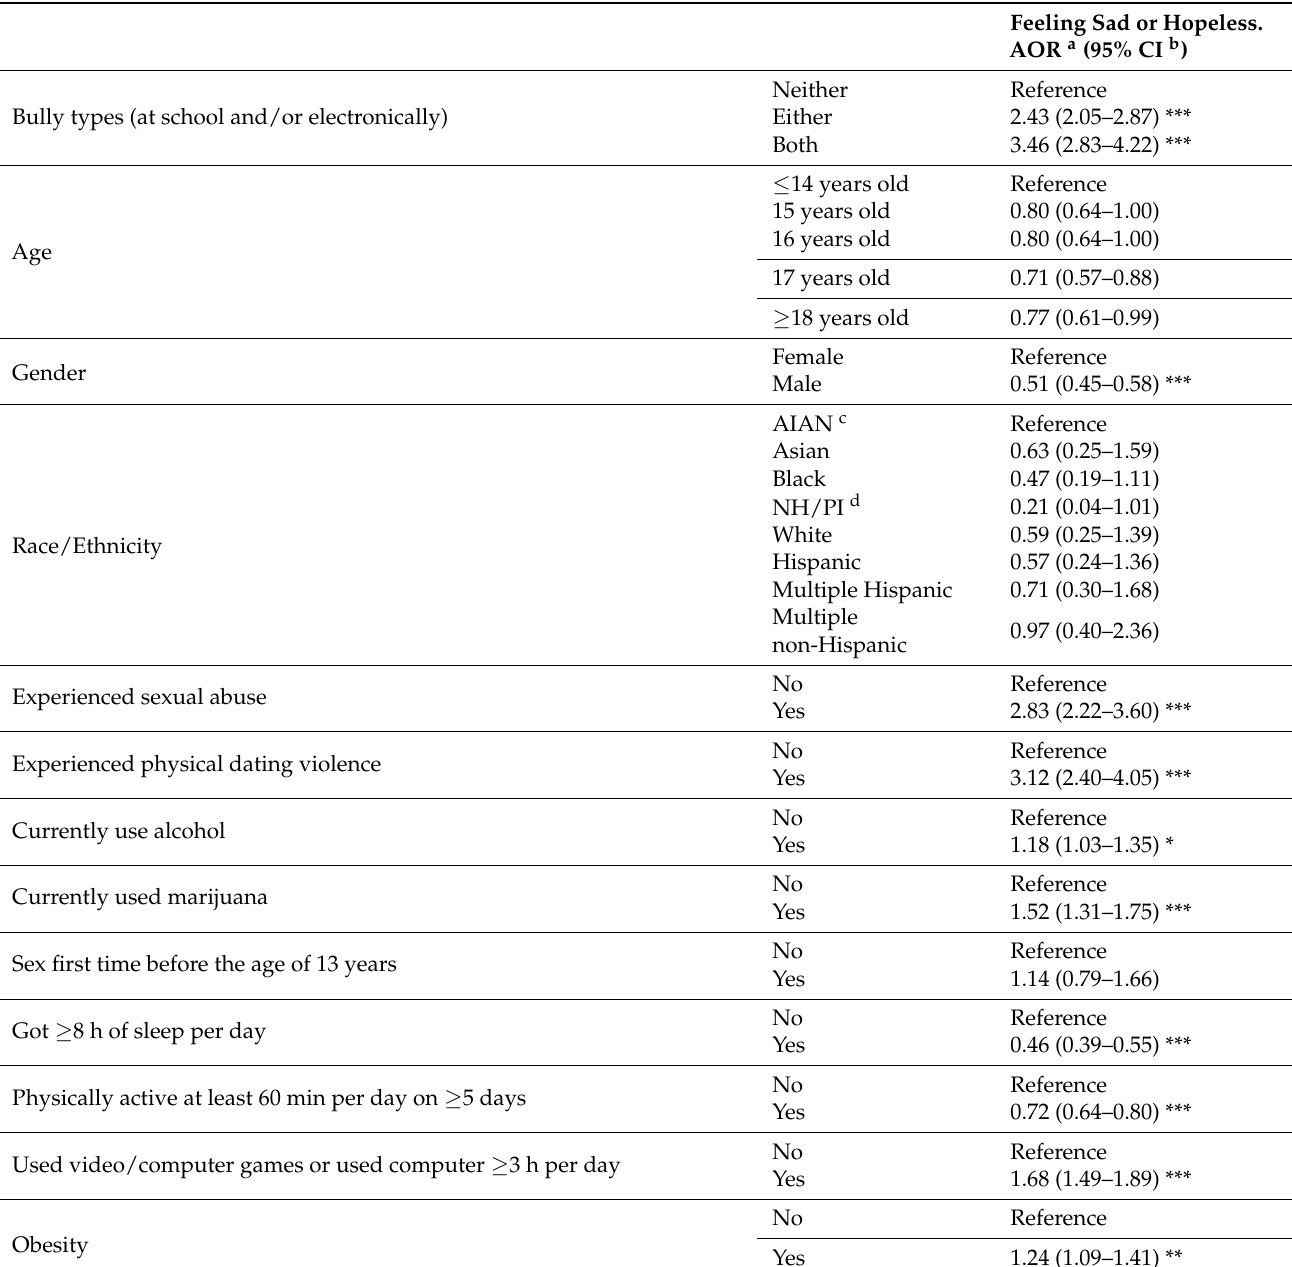
Table 4. Adjusted logistic regression of the association of being bullied with the depressive symptom of sadness and